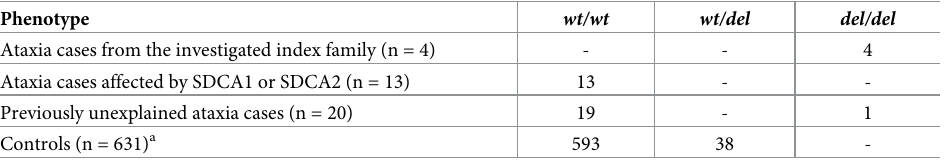
Table 1. Association of the SELENOP deletion with ataxia in 668 Belgian Shepherd